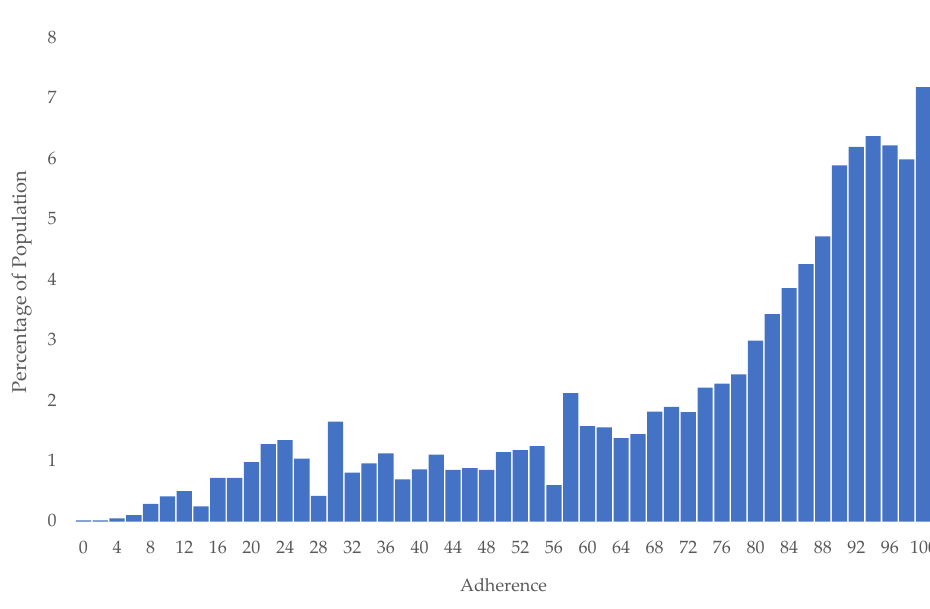
Figure 4. Frequency histogram of statin adherence.